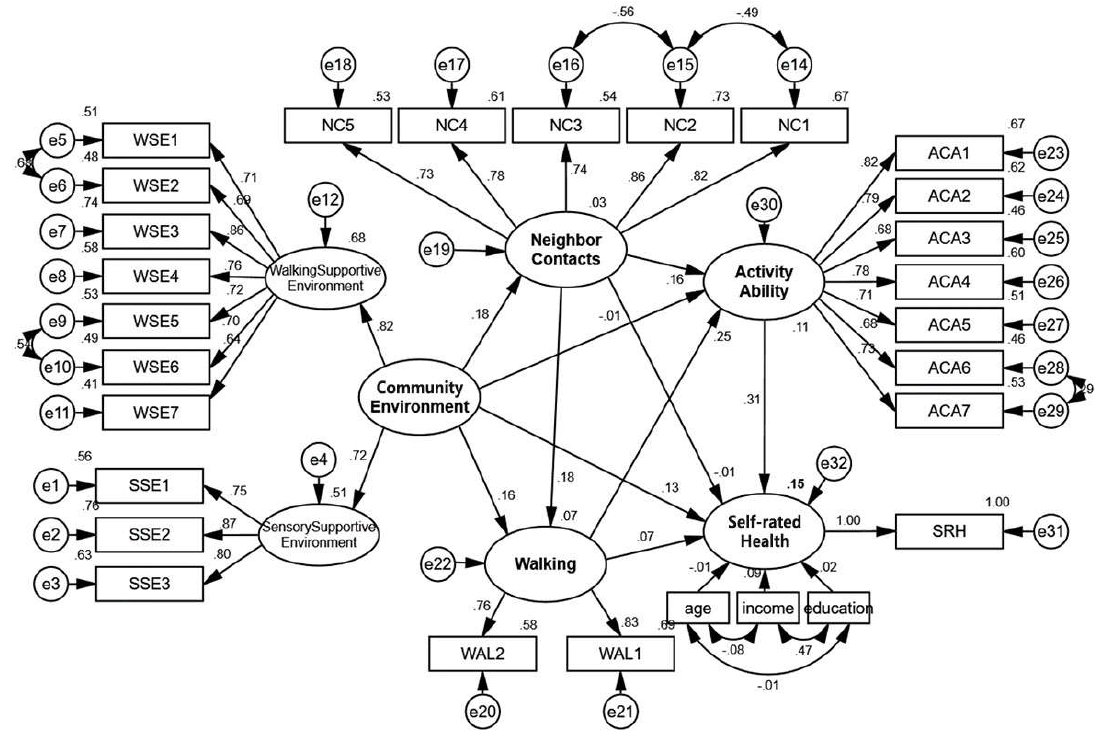
Figure 3. Standardized path diagram for the whole sample model.